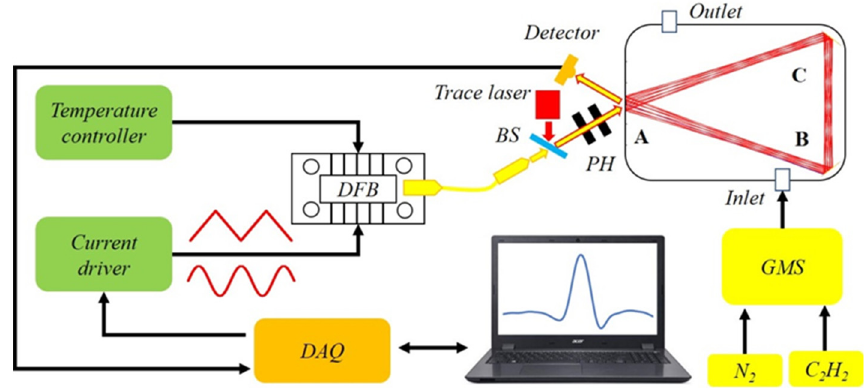
Figure 9. Schematic of the near-infrared C 2 H 2 sensor system using the three mirror-based gas cell, including an electrical system, an optical system, as well as a gas sampling system.